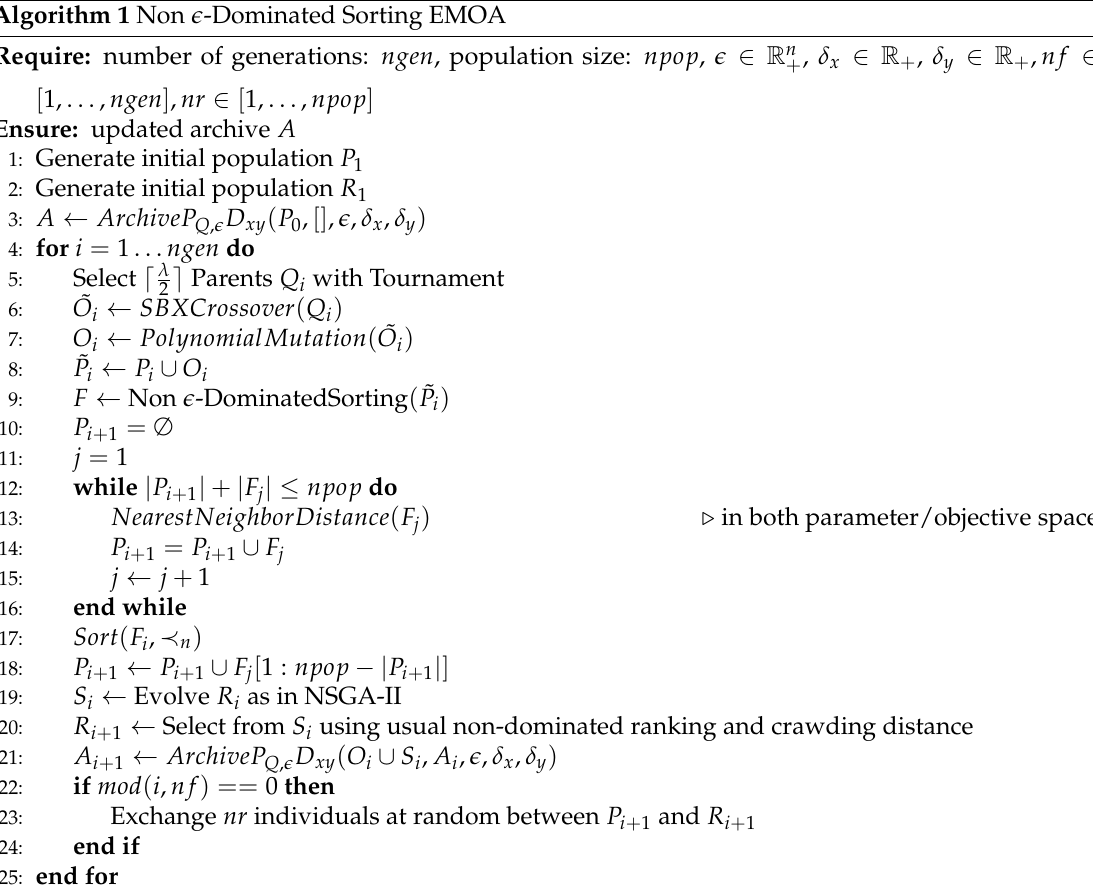
Algorithm 1 Non (cid:101) -Dominated Sorting